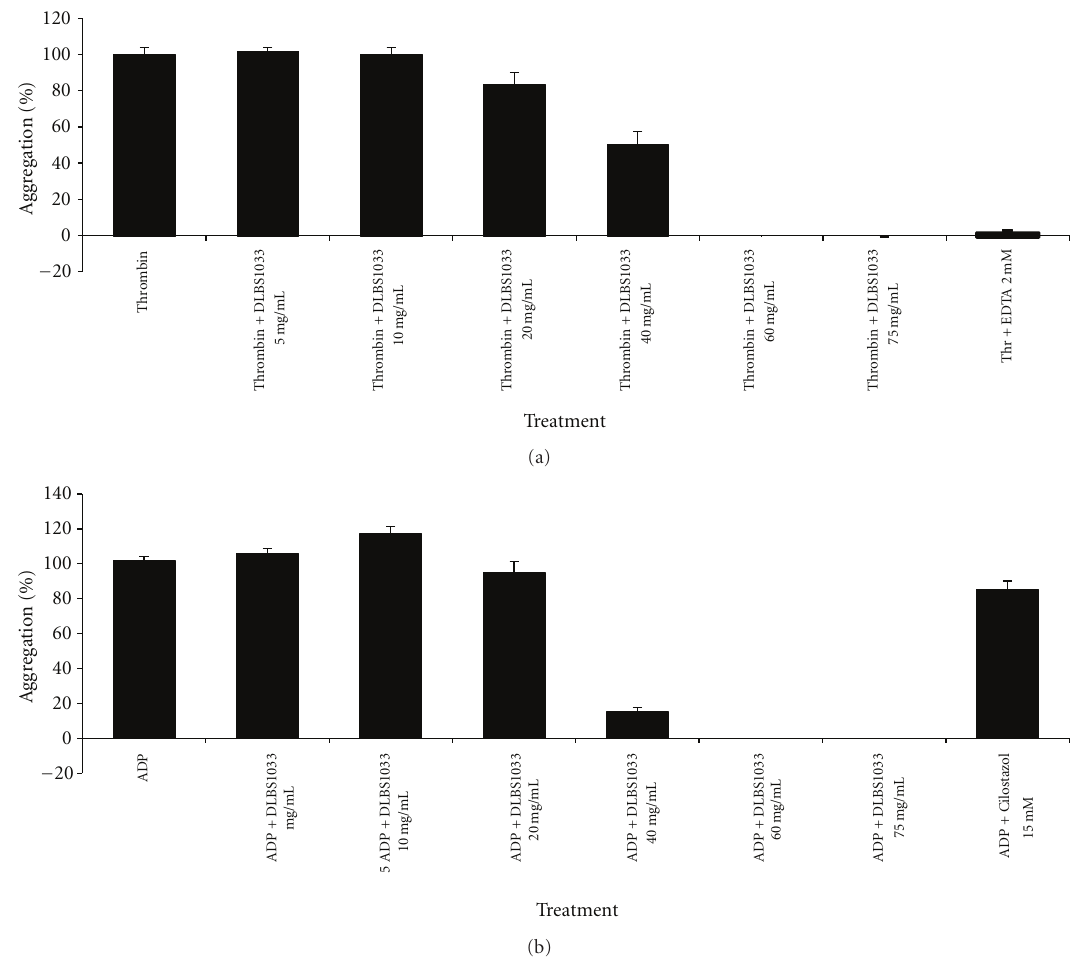
Figure 7: Inhibition of platelet aggregation by DLBS1033. Platelet aggregation induced by thrombin (a) and ADP (b) was downregulated by the administration of DLBS1033. EDTA and cilostazol were used as the positive control.